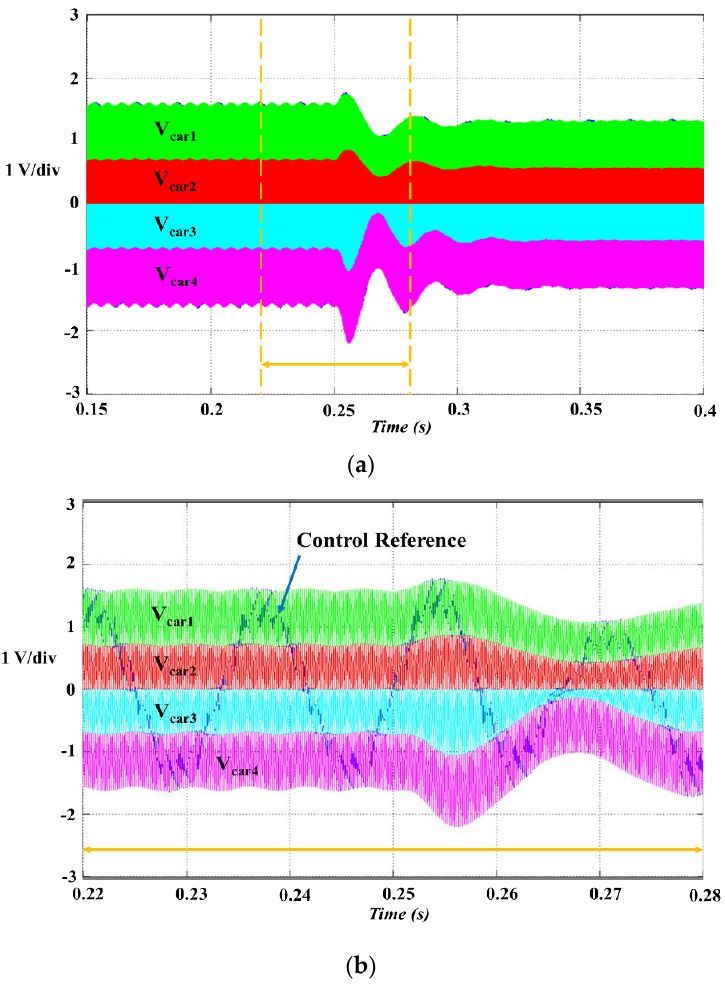
Figure 9. Simulation waveforms of the level-shifted OCC control. ( a ) Four carrier signals ( V car 1 - V car 4 ) and control reference for Phase A; ( b ) Zoomed carrier signals and control reference for Phase